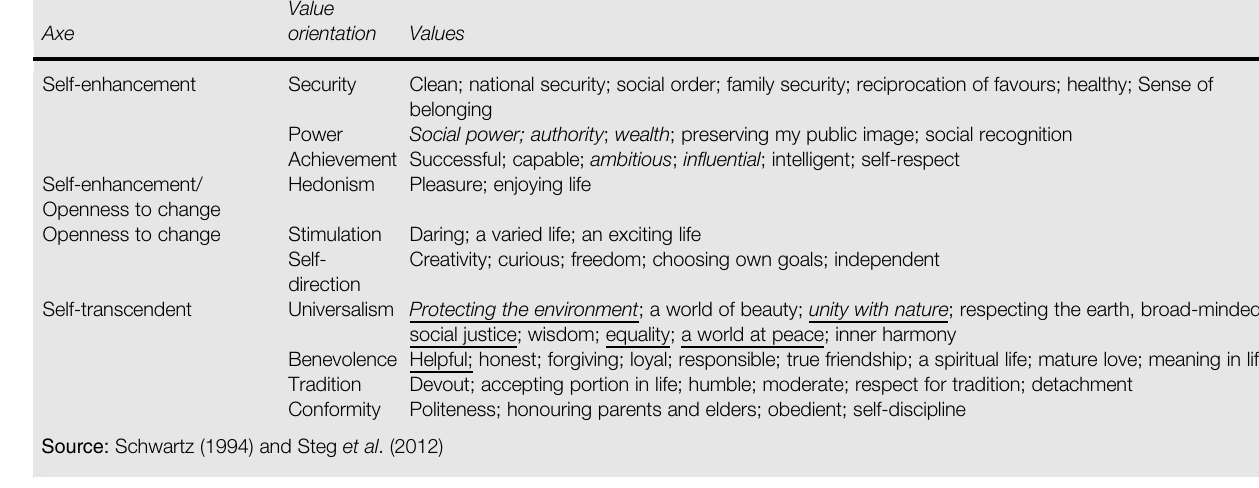
Table I Value orientations and